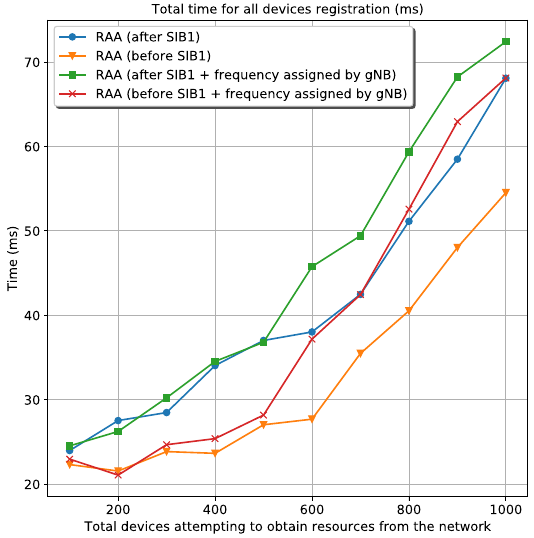
Figure 4. Total time spent by all the devices attempting to obtain resources from the network in Wi-Fi using the 28-bit clock frequency